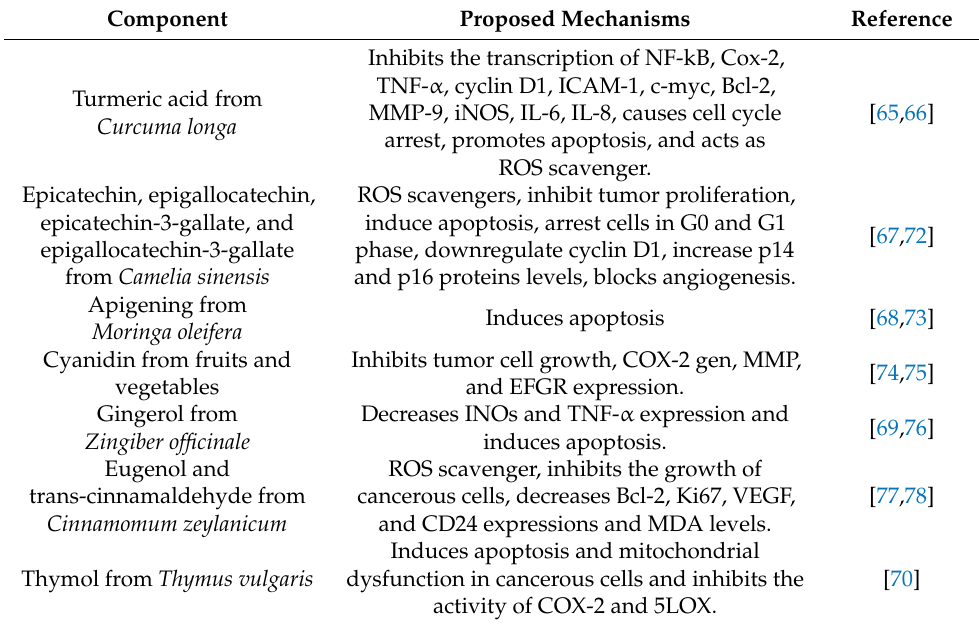
Figure 5. The antioxidant capacity of secondary metabolites in essential oils reduces the oxidative stress of oral tissue produced by free radicals and ROS. Table 3. Anticarcinogenic mechanisms of some plant compounds used in dental products.